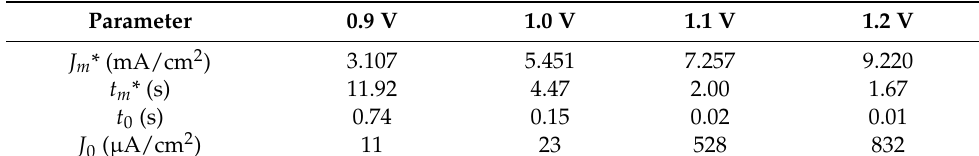
Table 1. Parameters of the electropolymerization of pyrrole at different anodic potentials obtained from the curves in Figure 1.